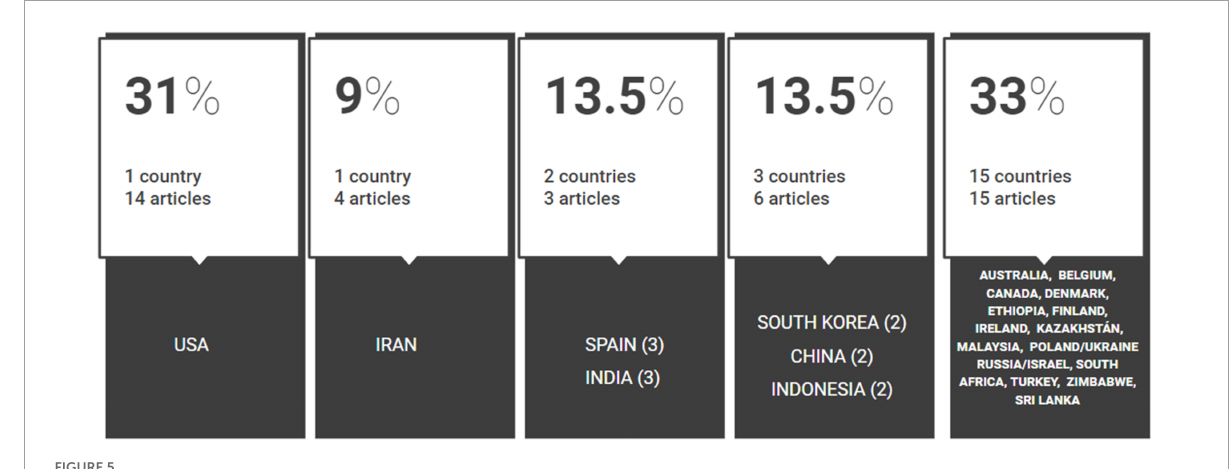
FIGURE5 Geographical provenance ordered by number of